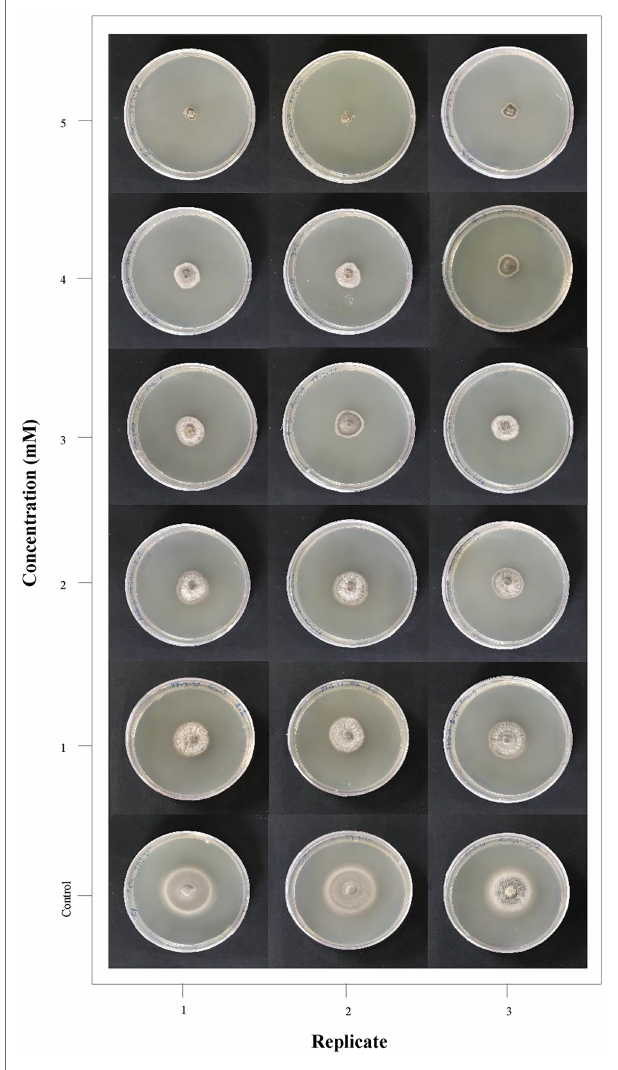
FIGURE 1 | Antifungal activity of ZnO nanoparticles (NPs) synthesized using the Camellia sinensis leaf extract. Magnaporthe grisea growth on different concentrations of medium containing ZnO NPs (0–5 mM) is represented in three replicates for visual